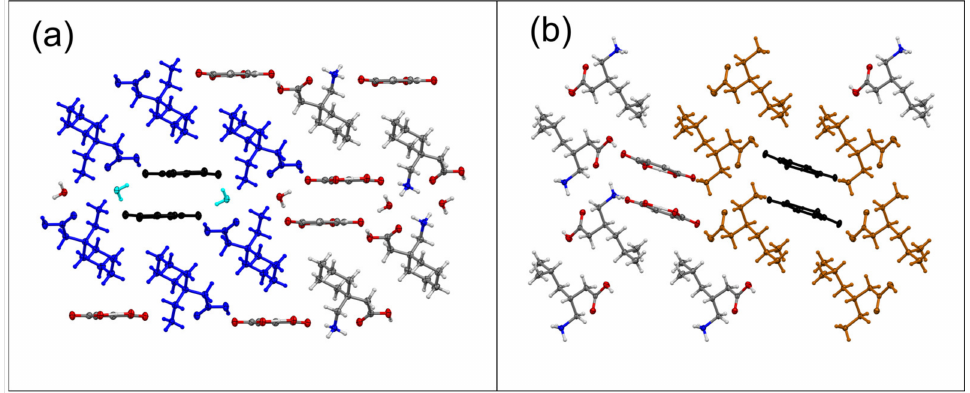
Figure 2. Packing in ( a ) 2-MA • H 2 O , view along the c-axis and ( b ) ( rac )-3-MA view along the b-axis. Motifs are highlighted according to the chosen color scheme; oxygen atoms are depicted in red, nitrogen atoms in white, carbon atoms in grey and hydrogen atoms in